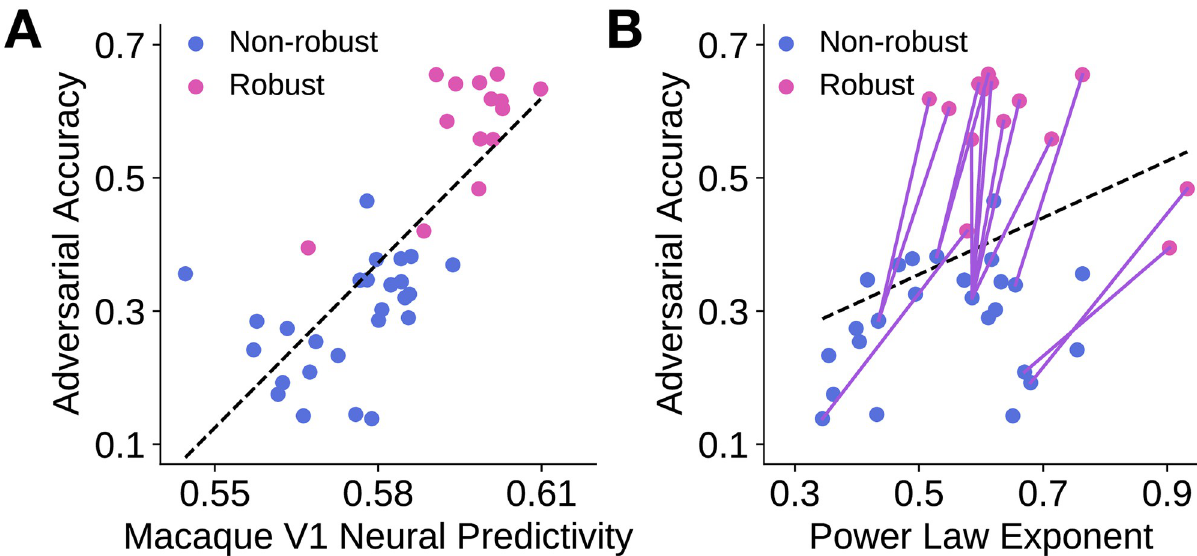
Fig 6. Adversarial accuracy is correlated with V1 neural predictivity and is weakly correlated with power law exponent. Each model is represented by a dot in each subfigure, with blue denoting non-robust models and pink denoting robust models. Dashed line indicates the line of best fit through the data points. A . A model’s adversarial accuracy is plotted against its (maximum) V1 neural response predictivity. As mentioned previously, neural predictivity was defined to be the noise-corrected Pearson correlation between the predicted and observed neural responses. R = 0.772, p < 0.001. B . A model’s adversarial accuracy is plotted against the power law exponent of its most “V1-like” layer, which was determined by neural predictivity. Each purple line connects two models of the same architecture, where one is trained without robustness penalties (blue) and the other is trained with robustness penalties (pink). R = 0.362, p =